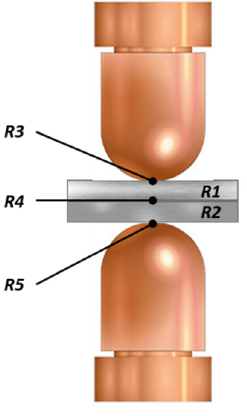
Figure 1. Resistances involved in a resistance spot weld.